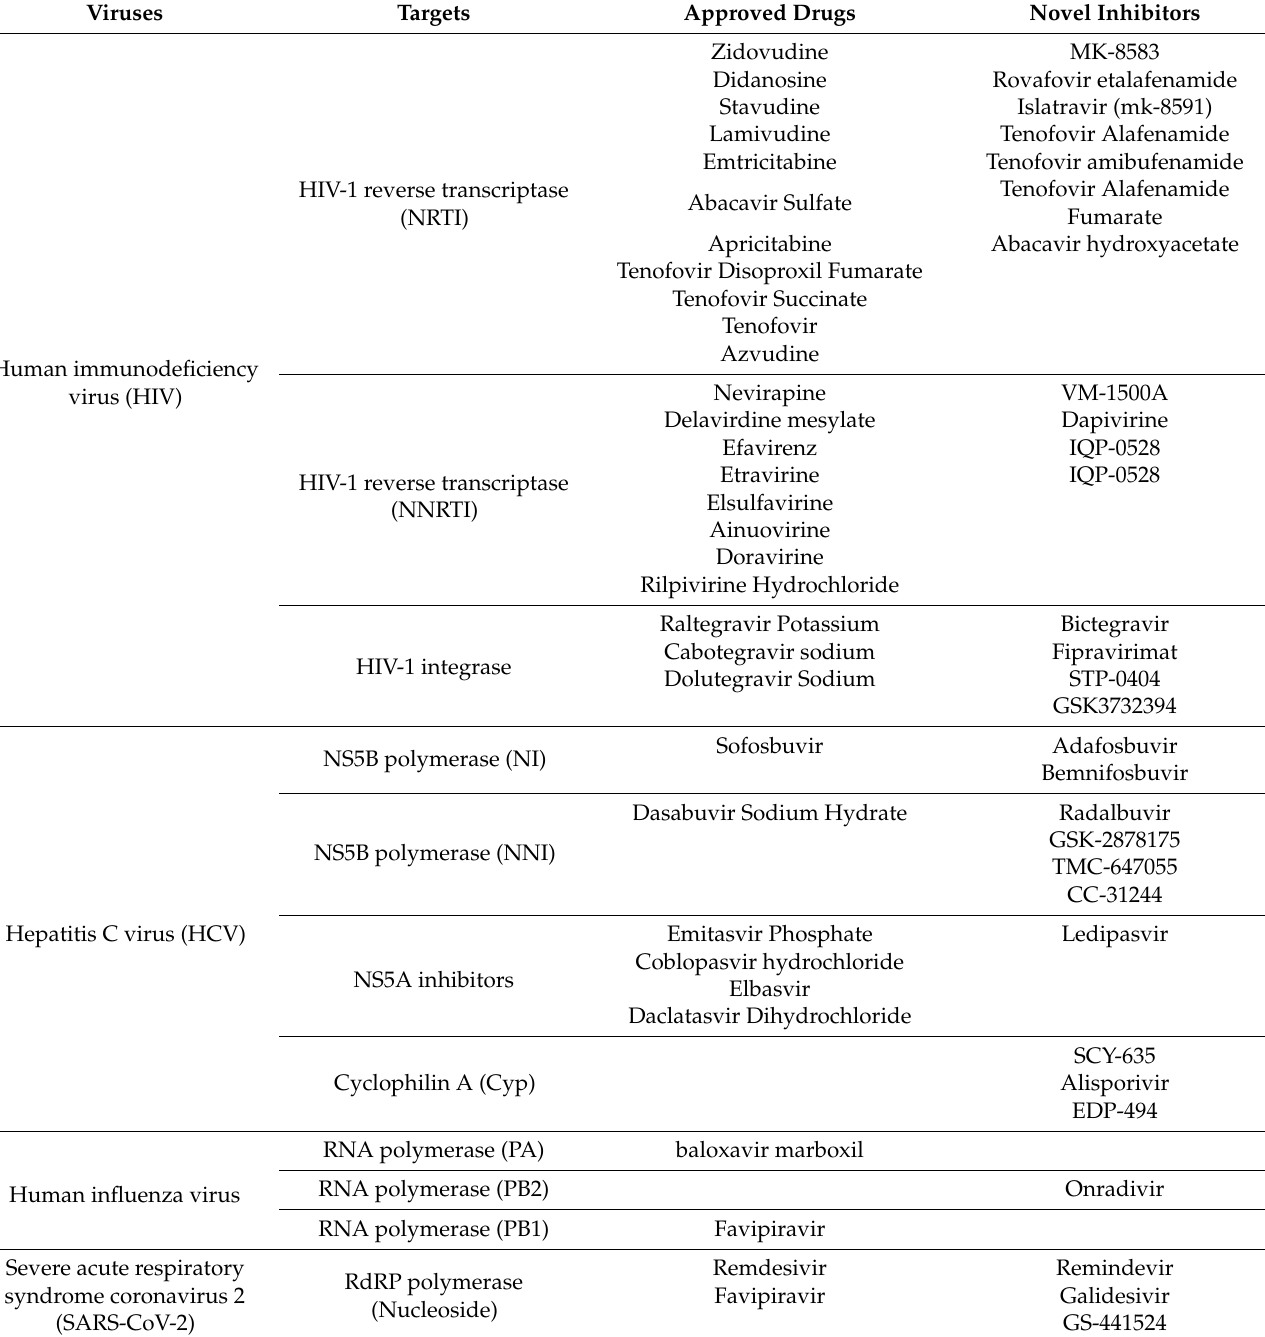
Table 1. Summary of approved drugs and compounds in development targeting DNA/RNA enzymes of common